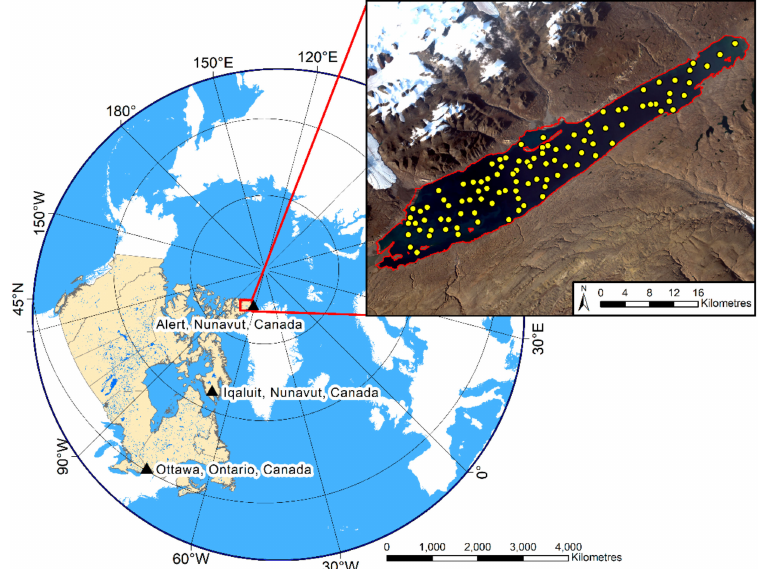
Figure 1. Lake Hazen located in Nunavut, Canada (71.05 ◦ W, 81.78 ◦ N). The longitude grids in the figure are at an interval of 30 ◦ , and the latitude grids are at an interval of 15 ◦ . The inset map shows the locations of the points used for validation. Landsat-8 Level-1 OLI / TIRS image courtesy of the United States Geological Survey (USGS) Digital Object Identifier (DOI) number: / 10.5066 /